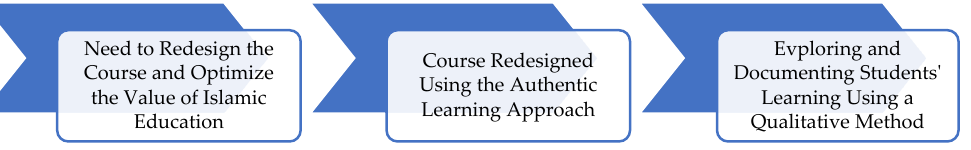
Figure 1. Research framework and process .